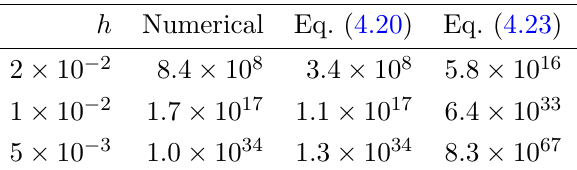
). For comparison, φ